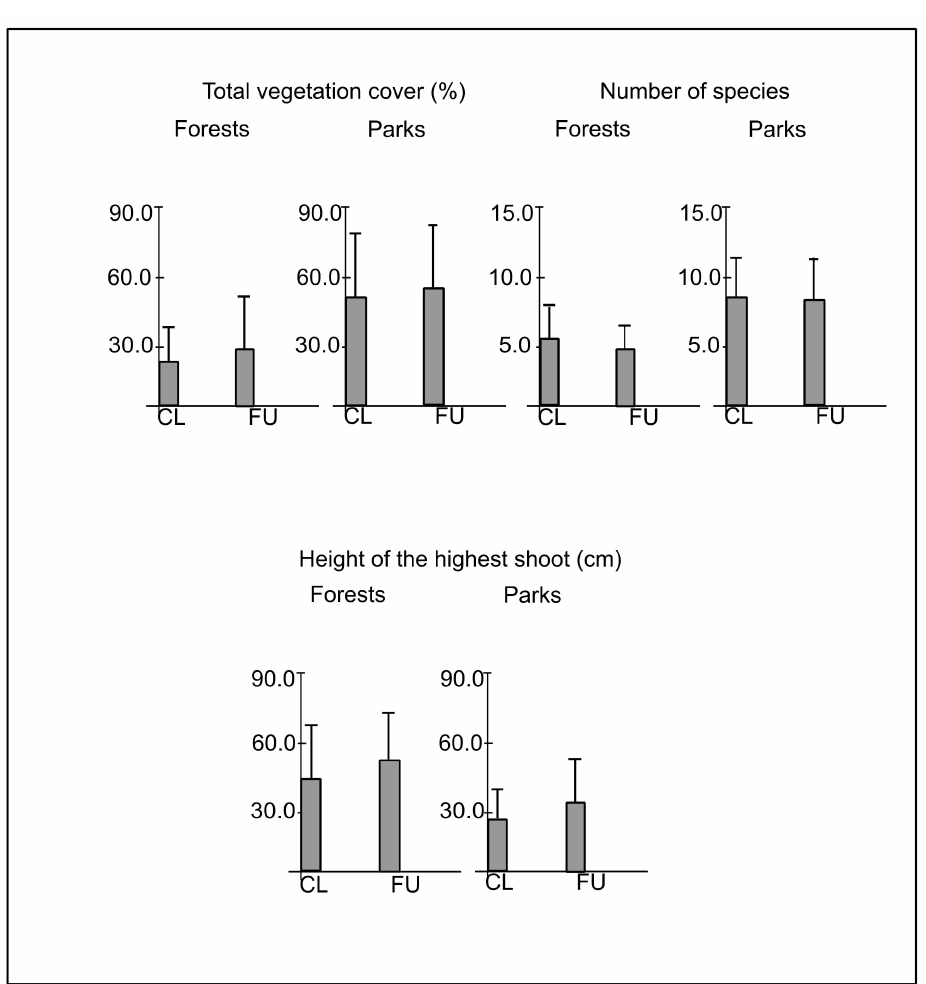
Figure 4. The mean (boxes) and standard deviation (whiskers) values of total vegetation cover, number of species and height of the tallest shoot in closer (CL) and further (FU) plots located along paths in forests and